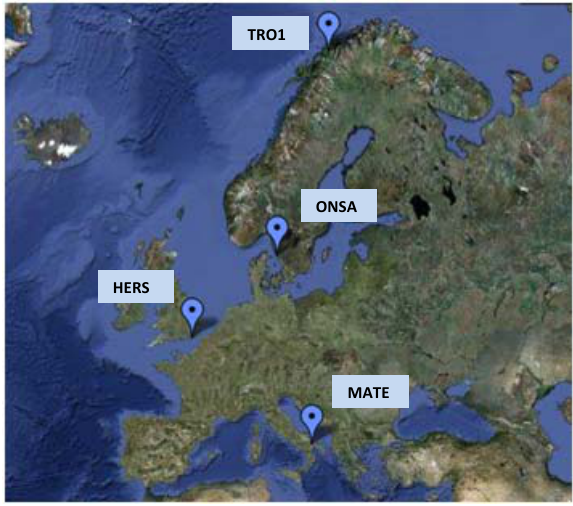
Fig. 1. The four IGS stations considered for this work in Europe. Station coordinates are provided in Table 1.